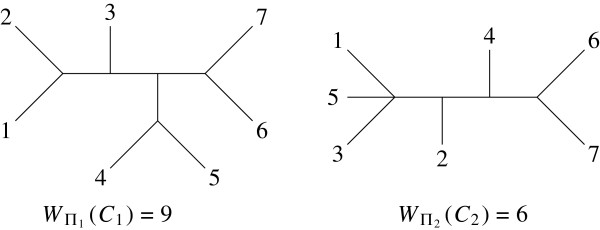
Consensus trees C1 and C2 of classes π1 and π2.